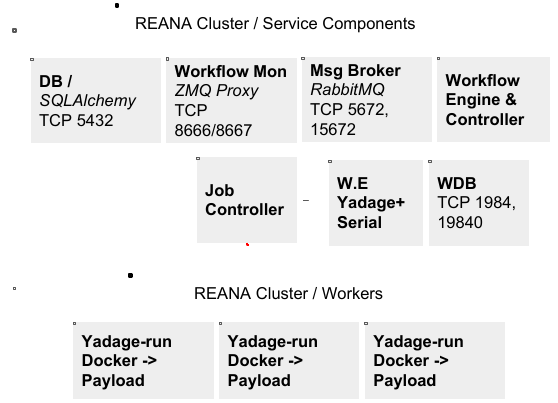
Figure 2 . Reana-cluster components. Each component runs in an individual container, with orchestration provided by